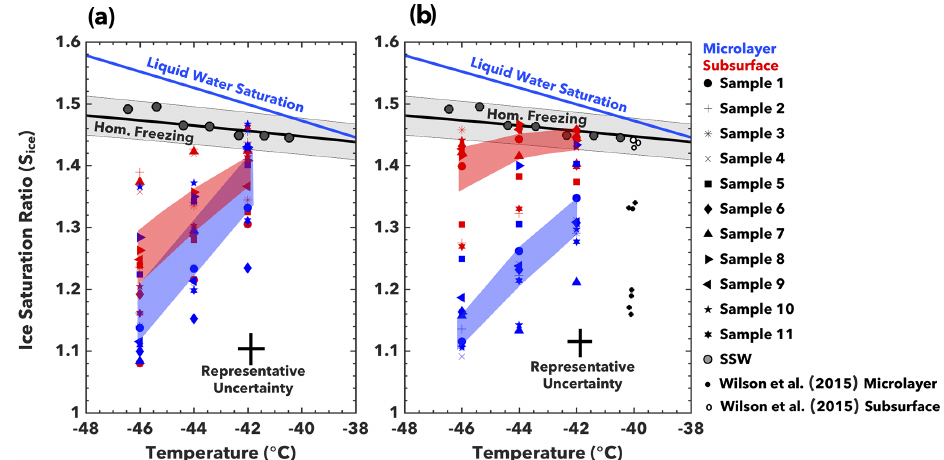
Figure 4. Deposition freezing. Conditions at the onset of deposition mode ice nucleation are shown for (a) ETNP and (b) Florida Straits seawater samples. The onset of ice nucleation is defined as when 1% of particles nucleate ice. Data points represent the average critical S ice value at − 46, − 44, and − 42 ◦ C. Shaded regions indicate the average critical S ice for all microlayer or subsurface samples, with a standard deviation of variability. Also illustrated are the conditions for homogeneous freezing for particles between 100 and 300nm in diameter (Koop et al., 2000), as well as the onset of homogeneous nucleation as measured in SPIN with synthetic seawater (SSW) aerosol. Representative uncertainty in onset conditions arises due to variability in SPIN lamina conditions (Garimella et al., 2016).